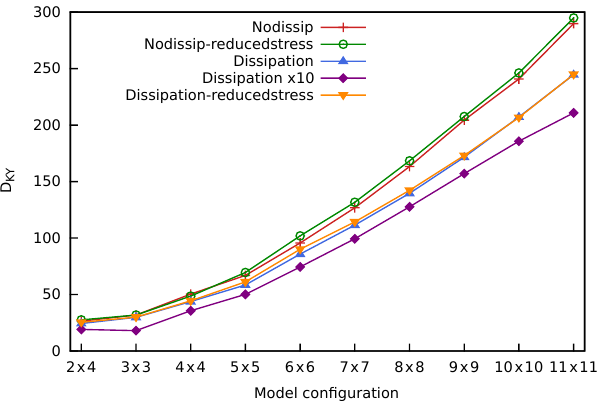
Figure 17. Kolmogorov–Sinai entropy h KS of MAOOAM as a function of the resolution for the different experiments. Colours as in Fig. 10.